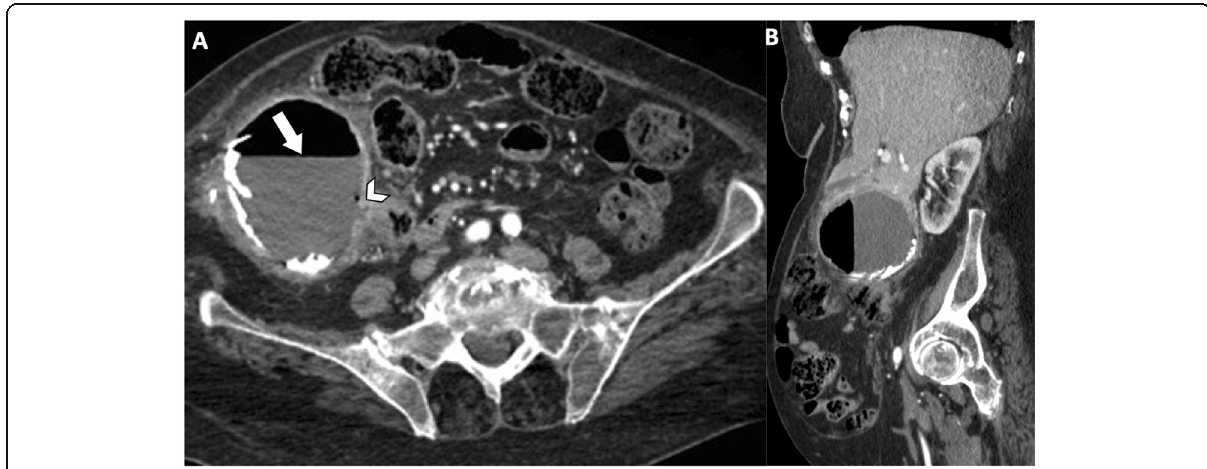
Fig. 11 An 85-year-old woman with hydatid cysto-colic fistulization. Axial contrast-enhanced CT image ( a ) and sagittal reformatted CT image ( b ) on portal venous phase demonstrate a large hepatic hydatid cyst with peripheral wall calcifications and air-fluid level (arrow), with frank communication (arrowhead) with the right